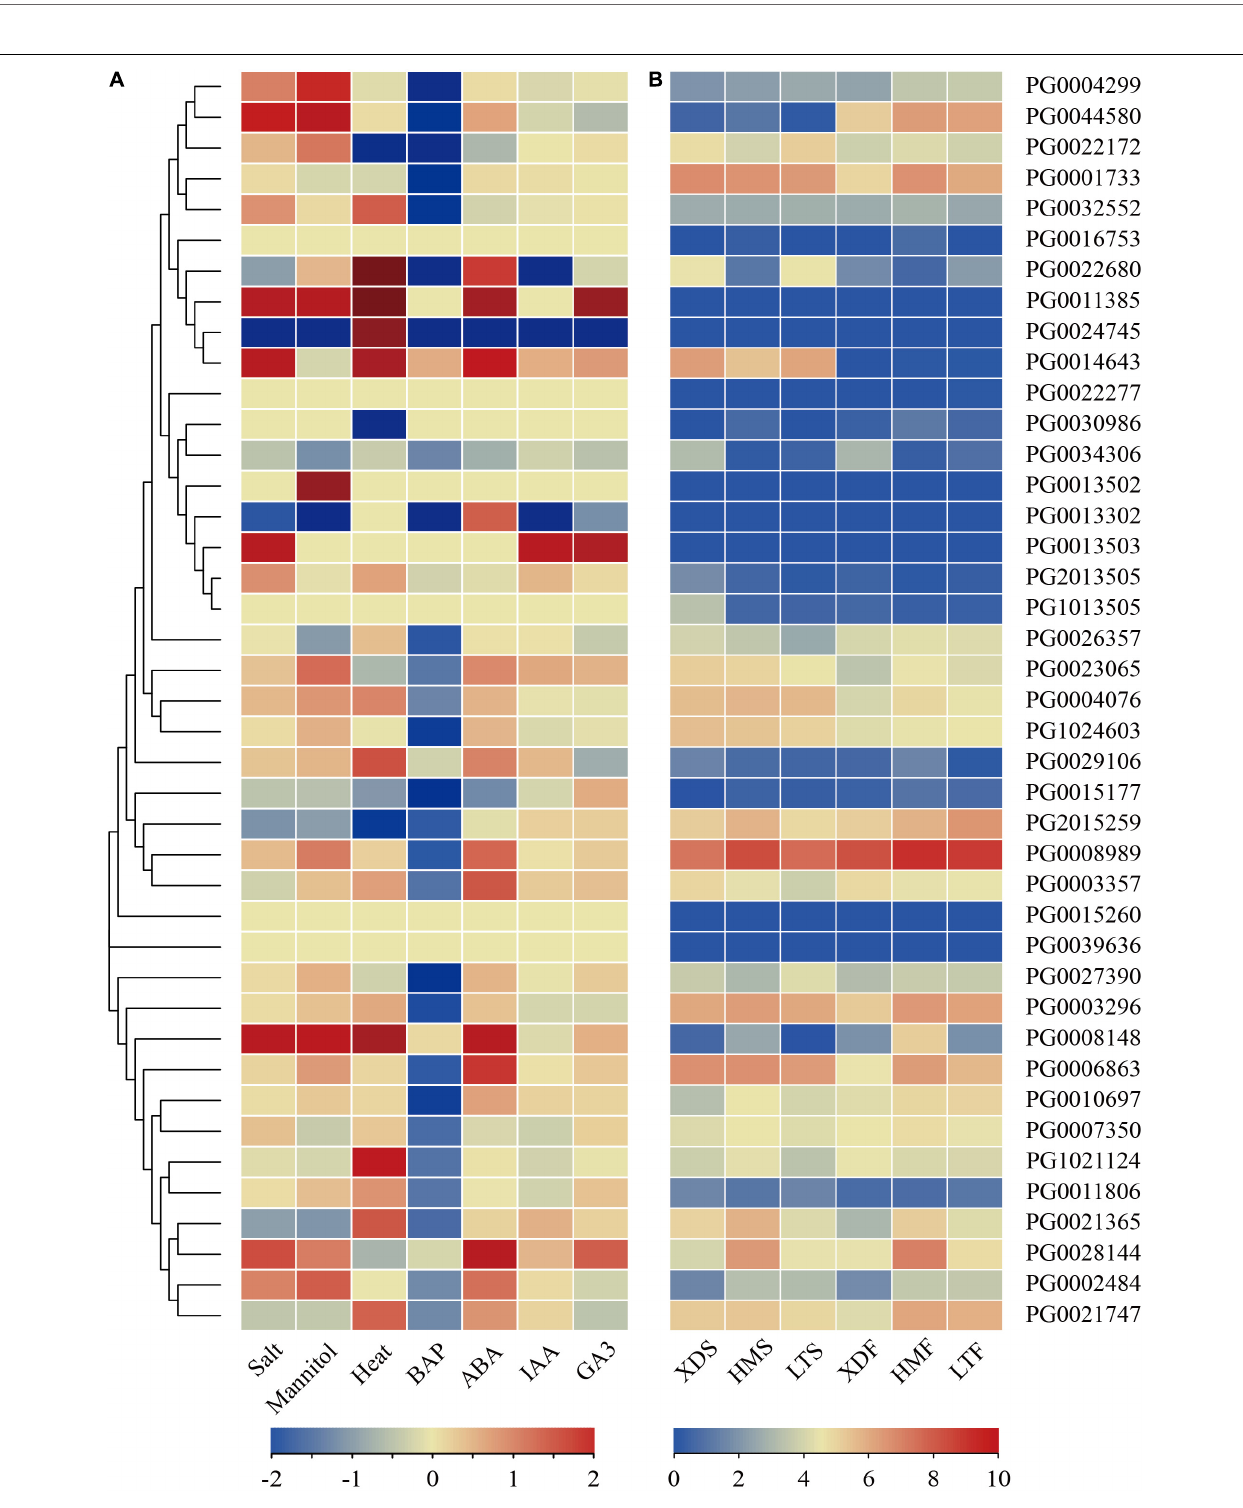
Frontiers in Genetics |